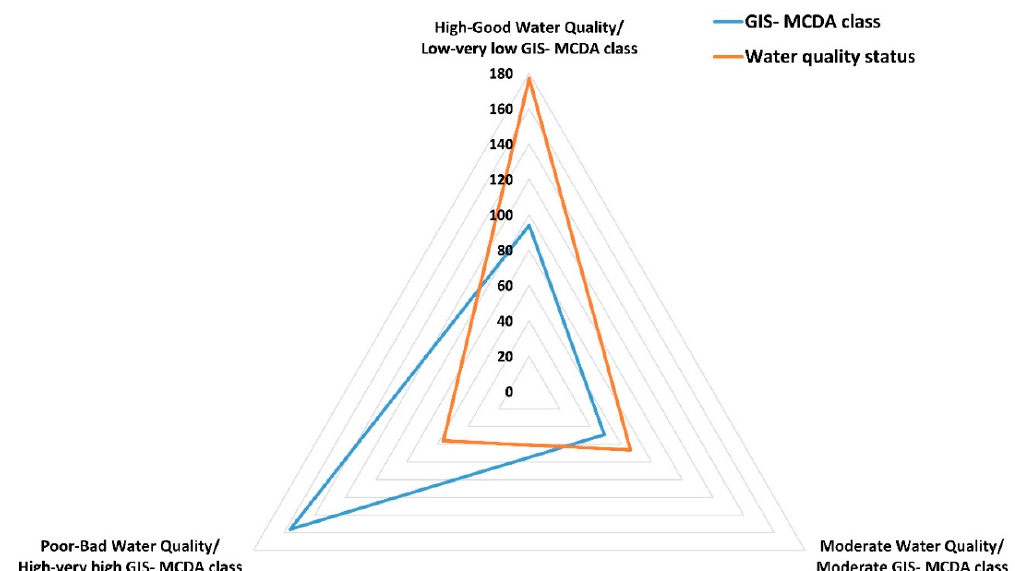
Figure 5. Comparison between water quality status in Greek rivers’ sampling points and need for monitoring as resulted from GIS-MCDA.